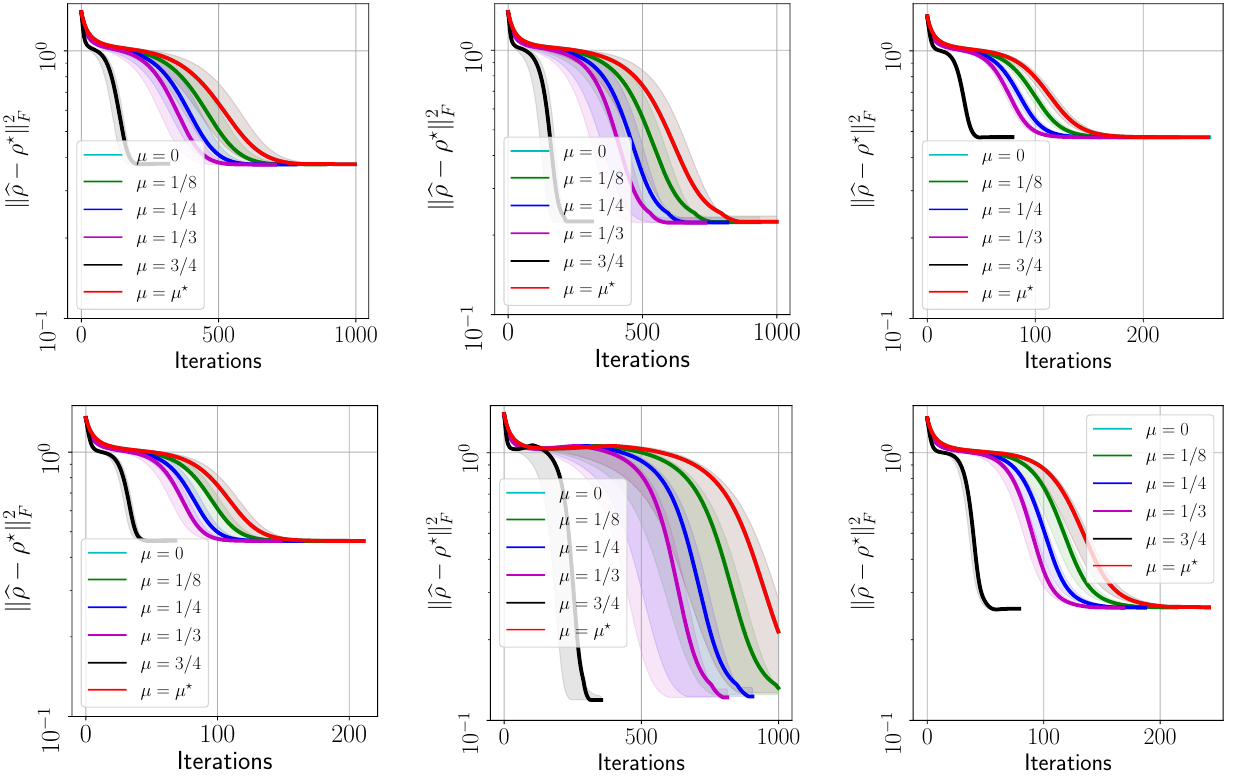
2 Figure 2. Target error list plots ρ ρ (cid:63) versus method iterations using real IBM QPU data. F (cid:107) − (cid:107) ( 6 ) with 2048 shots; Top-middle : GHZ ( 6 ) with 8192 shots; Top-right : GHZ Top-left : GHZ − − (cid:98) ( 8 ) with 4096 shots/copies of ρ (cid:63) ; Bottom-middle : Hadamard ( 6 ) with 2048 shots; Bottom-left : GHZ − 8192 shots; Bottom-right : Hadamard ( 8 ) with 4096 shots. All cases have measpc = 20%. Shaded area denotes standard deviation around the mean over repeated runs in all